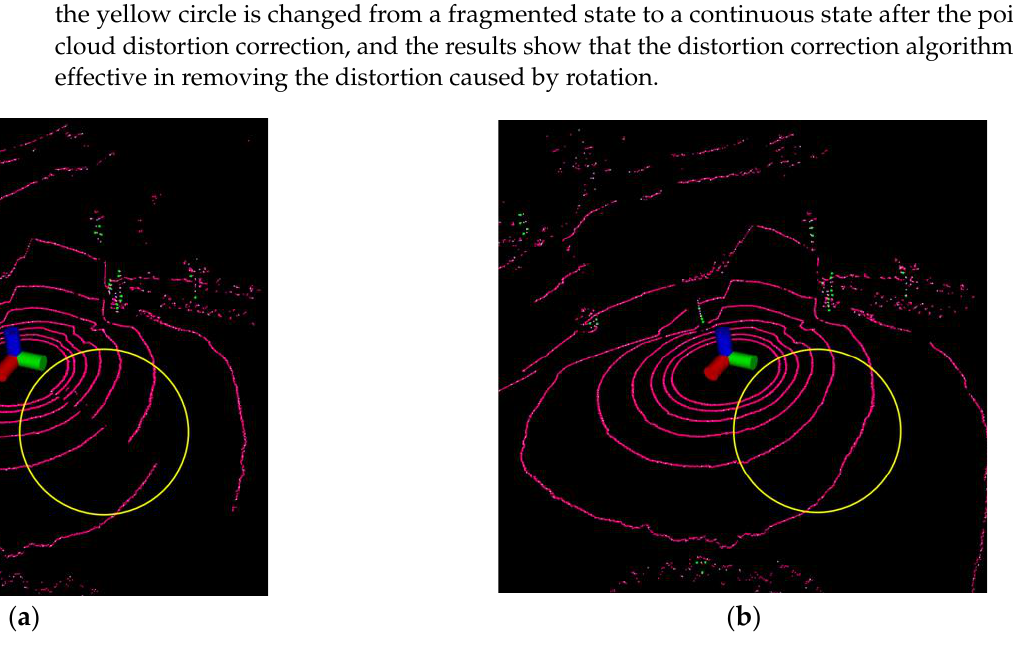
Figure 5. Point cloud distortion caused by translation. ( a ) Before distortion correction; ( b ) After dis- tortion correction.